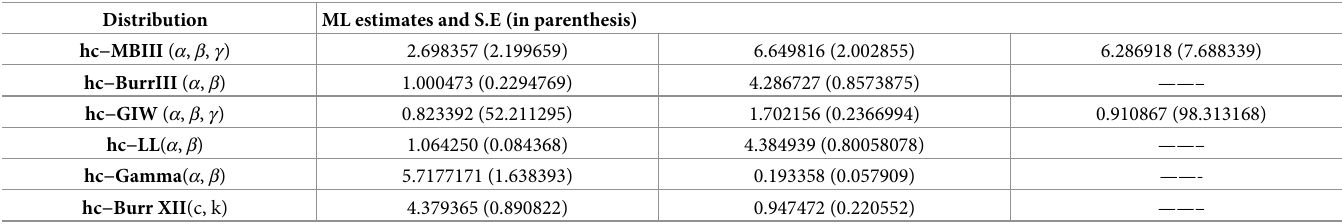
Table 2. ML estimates and S.E (in parentheses) for eye data. Distribution ML estimates and S.E (in